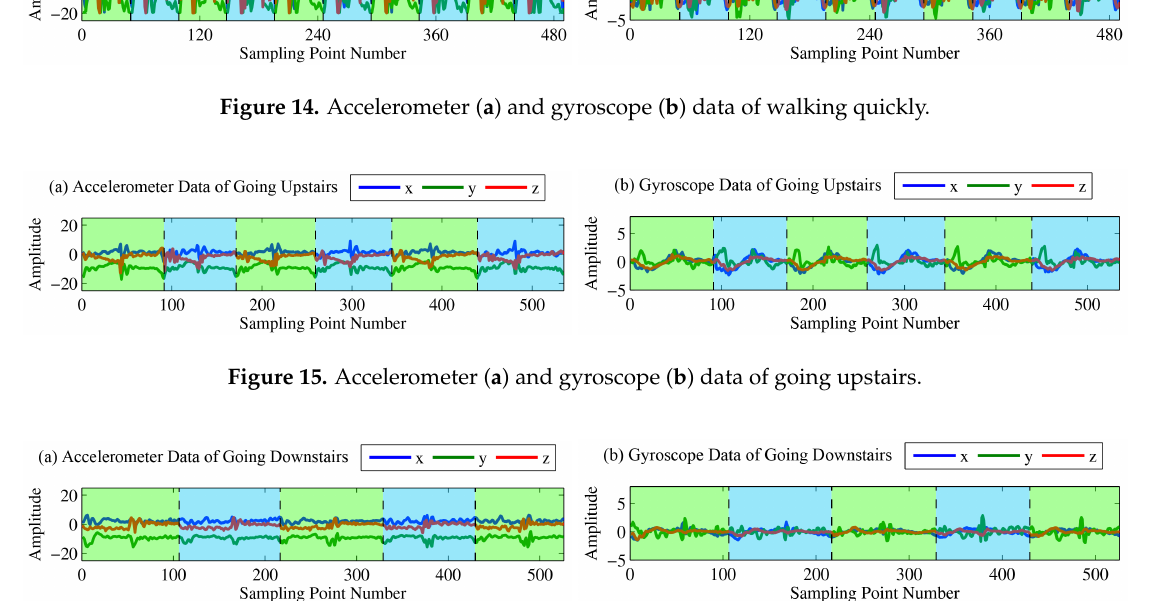
Figure 16. Accelerometer ( a ) and gyroscope ( b ) data of going downstairs.